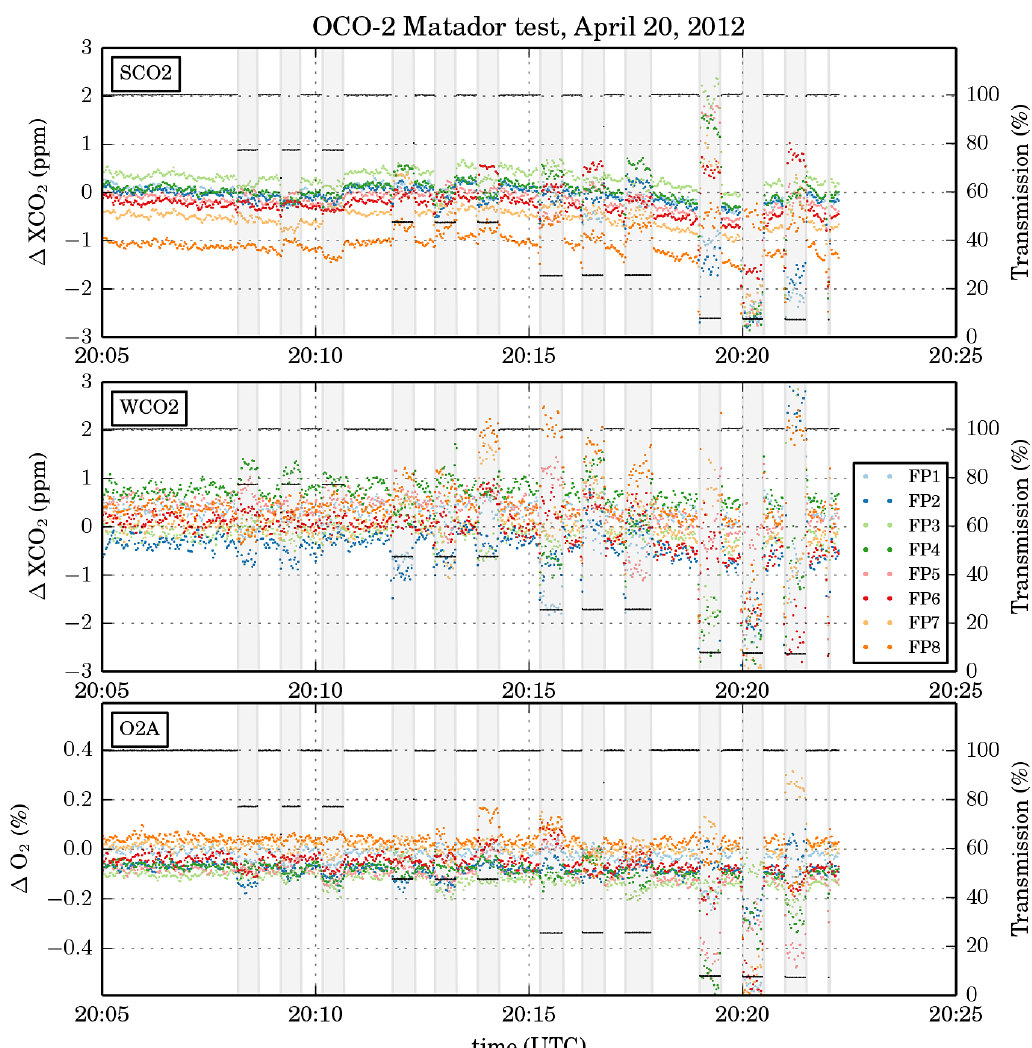
Figure 9. X CO (in ppm) and O 2 (in %) differences from a common average in the OCO-2 Matador test, which changed signal levels through 2 inserting aluminum sheets with variable hole density into the light beam. Gray shades indicate the time periods that the aluminum sheets were in the beam and the black horizontal lines indicate the transmission level for each of these tests. Each footprint for both CO 2 bands and the O 2 band is displayed